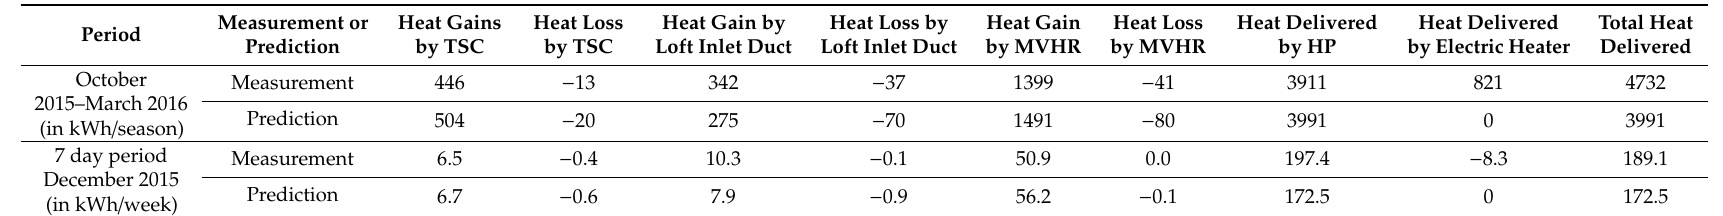
Table 6. A summary of predictions against measured data for the heating period and the selected example week